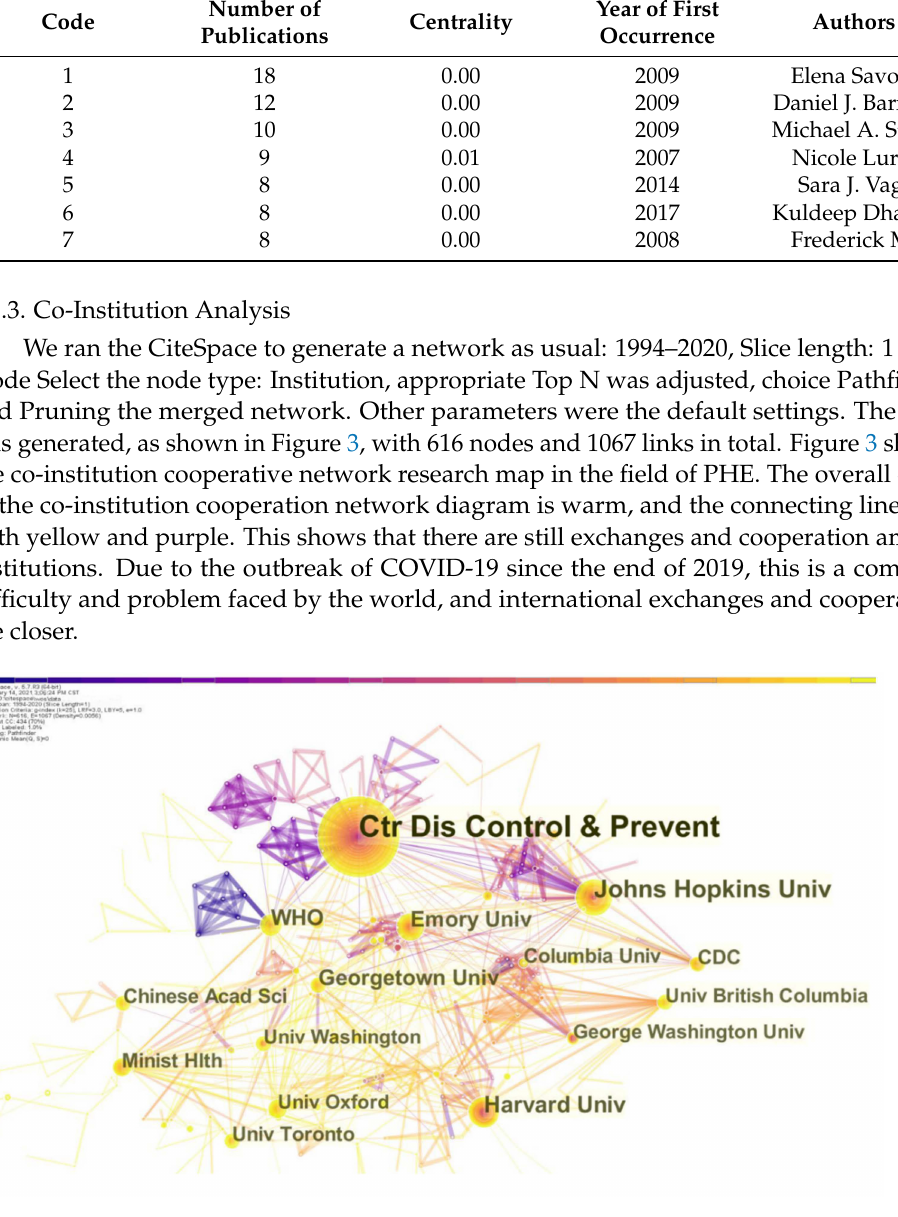
Figure 3. Co-institution network (1994–2020). Different colors represent different time slices, the larger the node, the more papers institutions have published. The thicker the line between the nodes, the closer the two institutions work